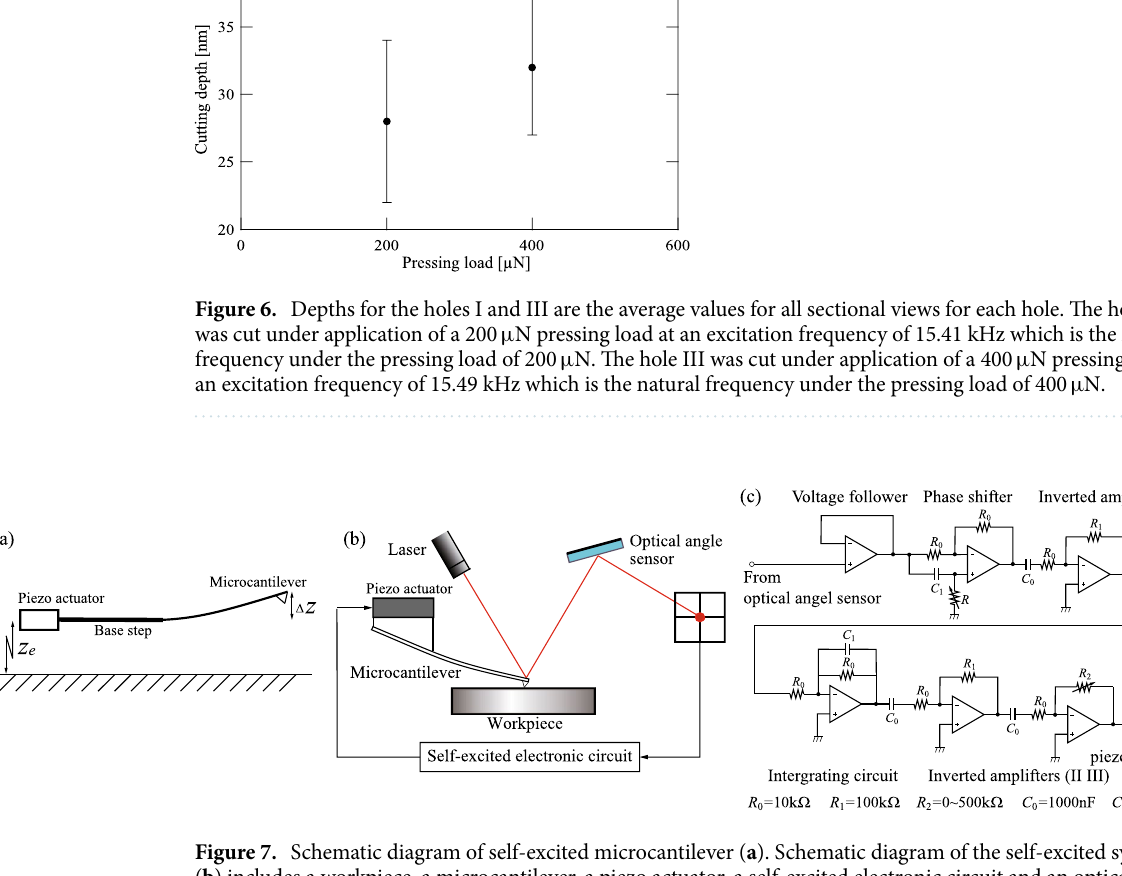
Figure 7. Schematic diagram of self-excited microcantilever ( a ). Schematic diagram of the self-excited system ( b ) includes a workpiece, a microcantilever, a piezo actuator, a self-excited electronic circuit and an optical lever that consists of a laser and a photodiode. Self-excited electronic circuit ( c ) includes a voltage follower, a phase shifter, an integrating circuit and three inverting the chip dropped and adhered on the surface of the workpiece. After the second cutting experiment, there was not chip adhered to the diamond. Therefore, there was not a bump in the third cutting experiment in which the hole III was cut with the resonance state of the microcantilever. Tables 1 and 2 in Appendix B summarize the depth of the holes I and III calculated by each sectional view. Table 3 in Appendix B summarises the cutting condition for each cutting hole and the depth of each cutting hole calculated in average for all sectional views. Figure 6 compares the depth of the cutting holes I and III. Com-